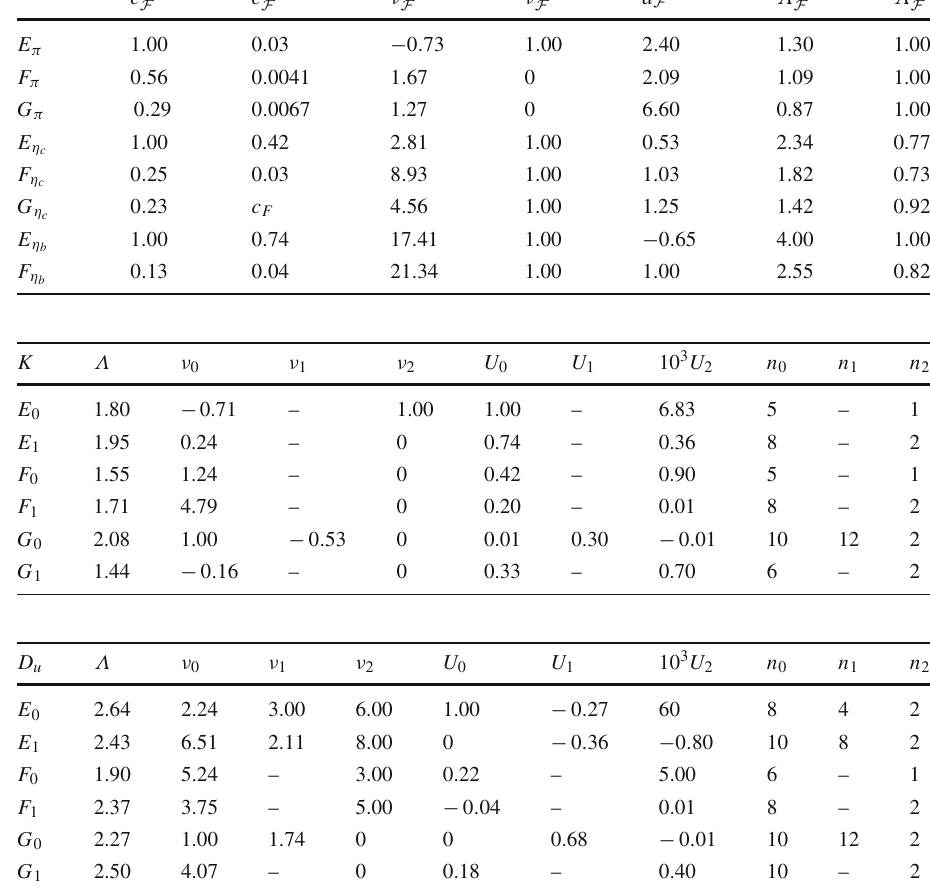
Table 6 Parameters of the BSA representation, Eqs. (60)–(65), for the π , η c and η b